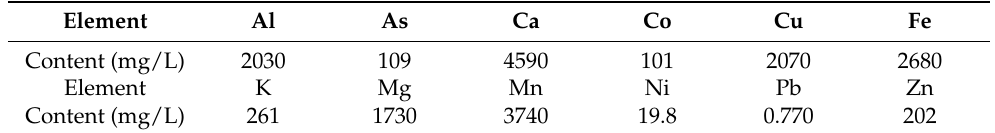
Table 1. Chemical analysis of